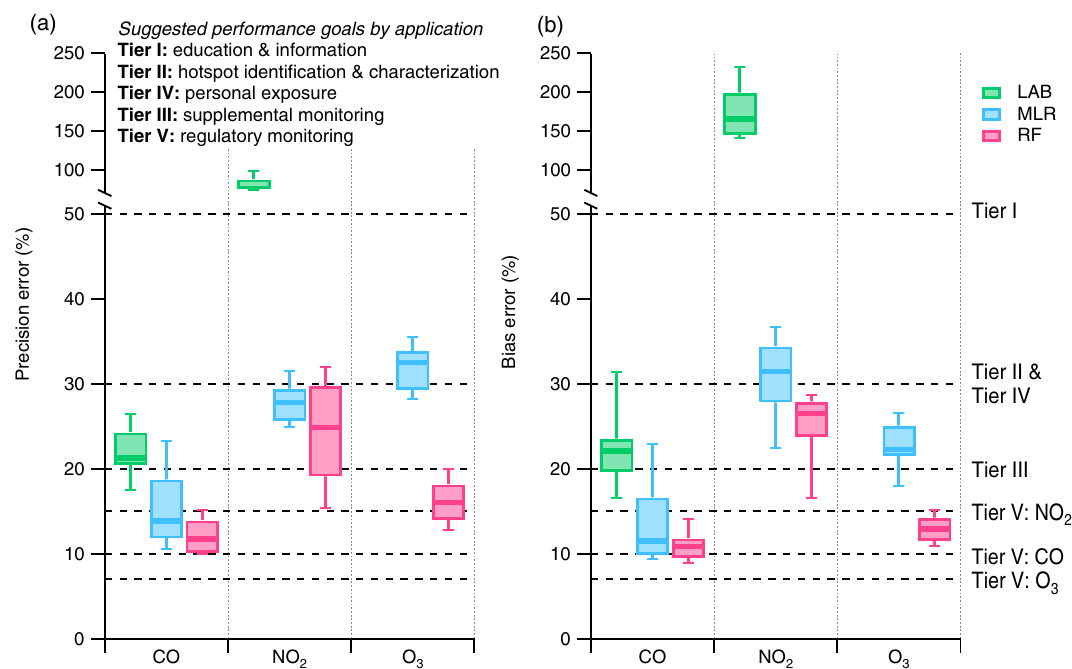
Figure 14. Precision (a) and bias (b) estimates of RAMP monitors calibrated using LAB, MLR, and RF models compared to the suggested performance goals by application as recommended in the EPA Air Sensor Guidebook. The precision estimator is the upper bound of the coefficient of variation (upper bound of the relative standard deviation, RSD). The box plots are the range of performance across the calibrated RAMP monitors (testing data only). The calibrated RAMP monitors meet the recommended error limits for exposure (Tier IV).